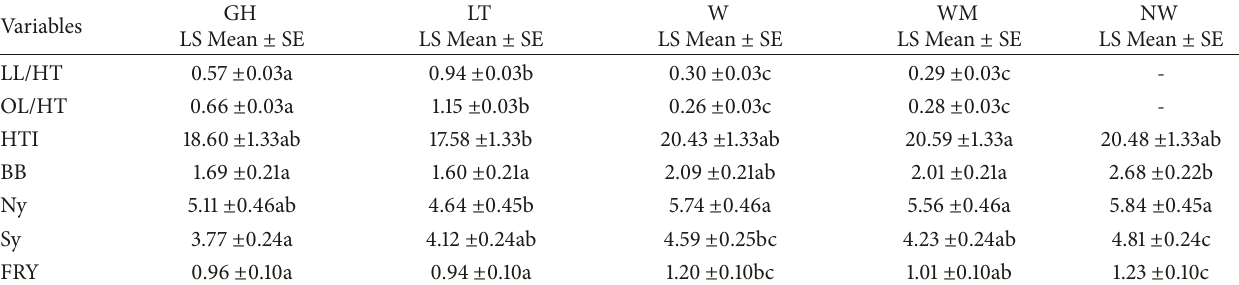
Table 5: Least square means and standard error of various response variables in seedlings treated with different inoculations.